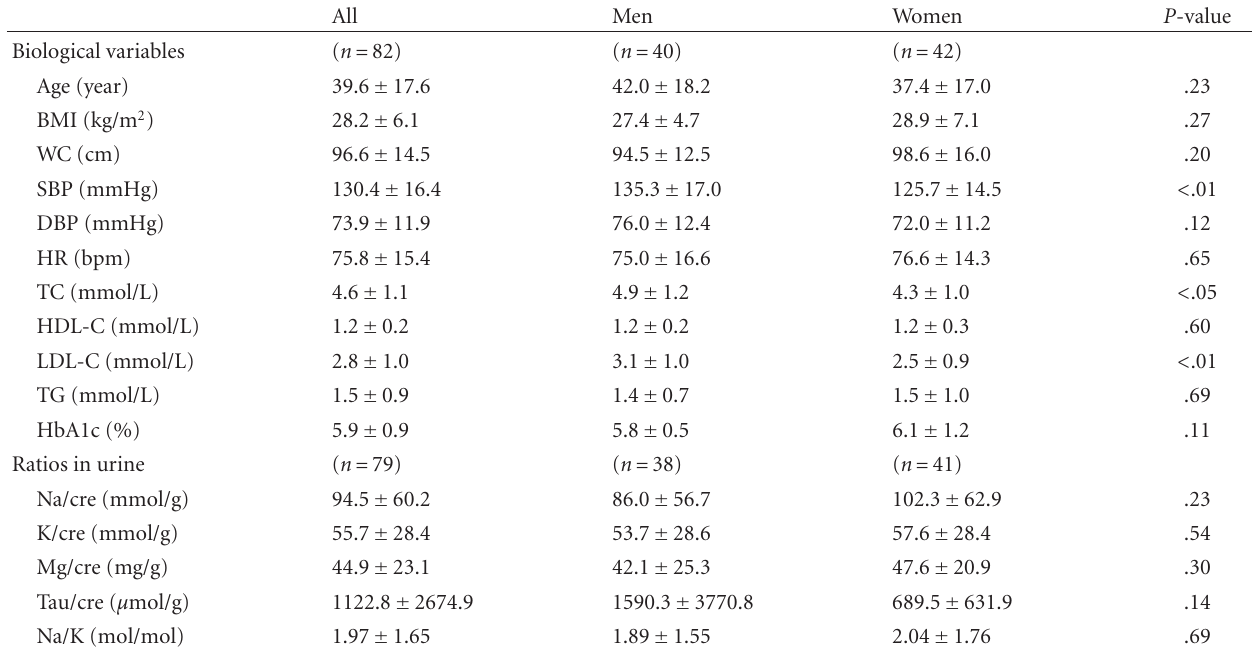
Table 1: Characteristics of study